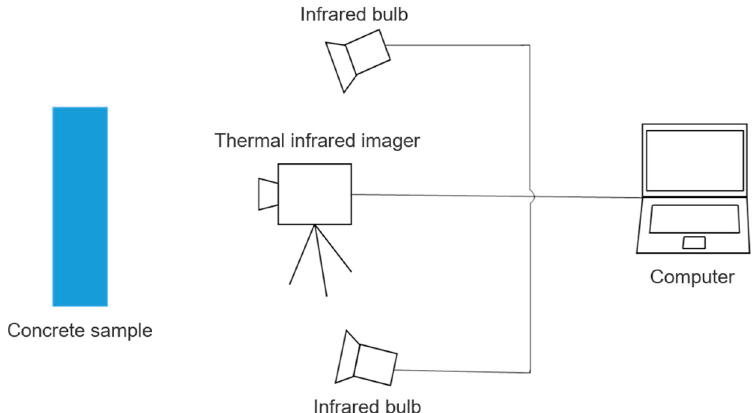
Figure 1. Infrared imaging detection system.